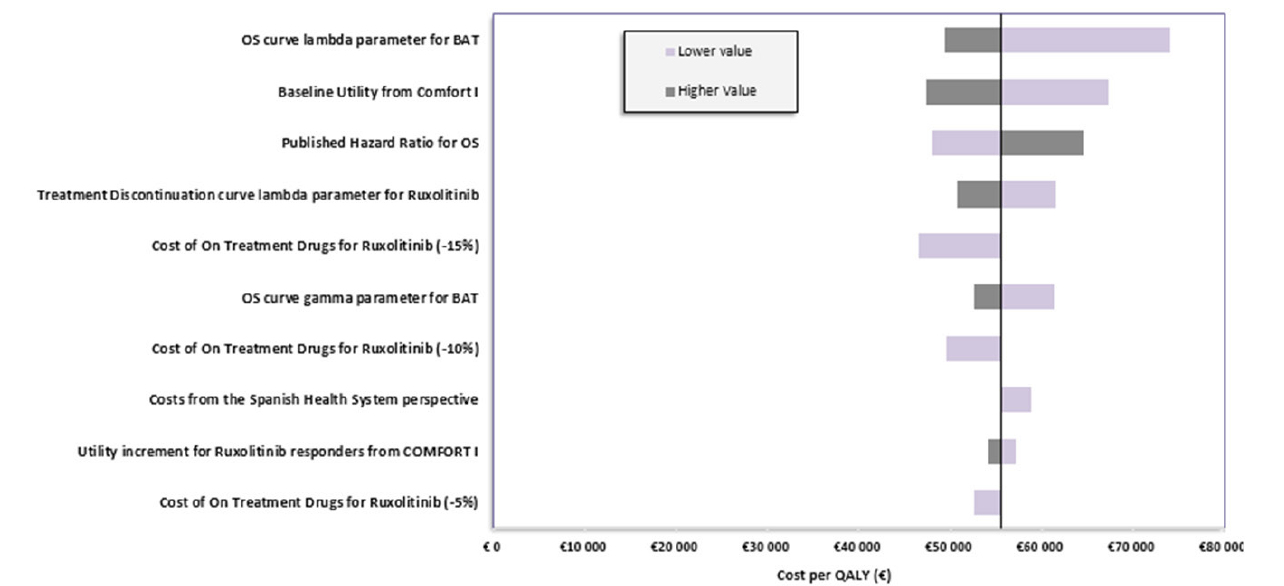
Figure 2. Tornado Diagram: ICER (cost/QALY) Variation Caused by Individual Variations of the Input Parameters